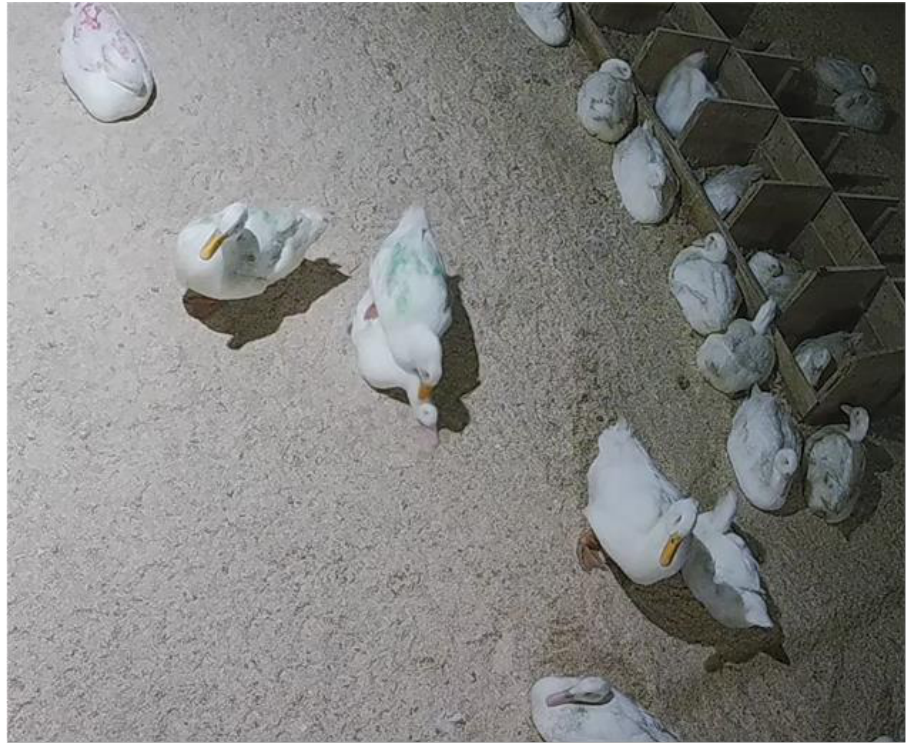
Figure 1. A marked focal Pekin drake performs a correctly oriented mount on top of a hen. The orientation is head-to-head and tail-to-tail.